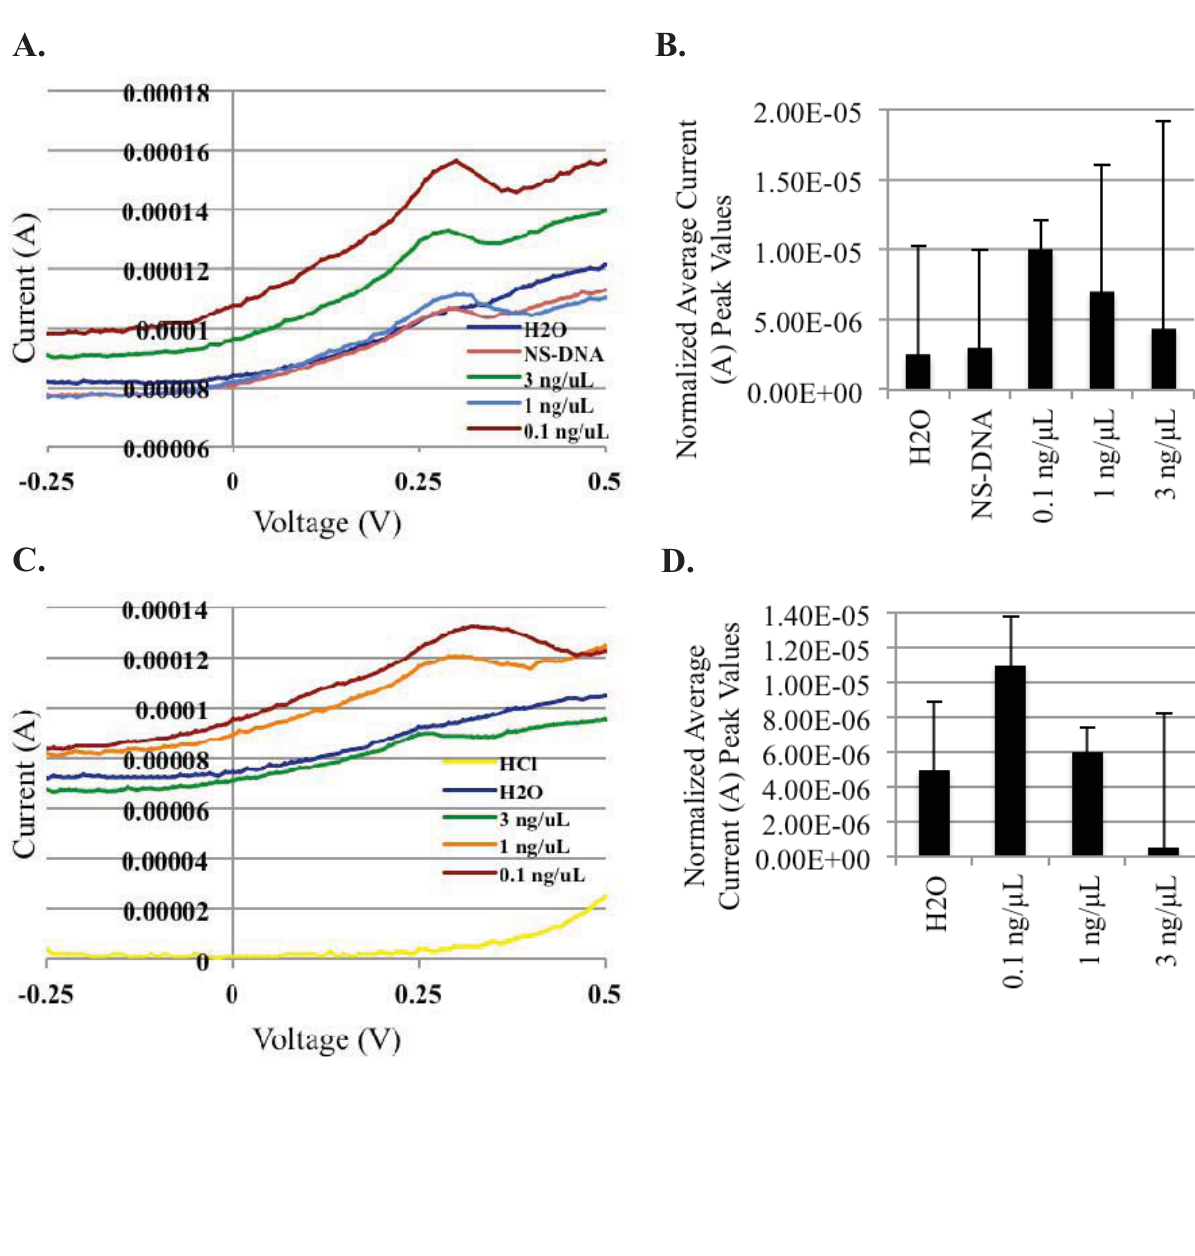
Figure 2. AuNP-DNA biosensor detection of non-PCR amplified S. enteritidis genomic DNAt. ( A ) Differential pulse voltammogram of PCR-amplified DNAt from S. enteritidis at various concentrations. ( B ) DNAt concentration vs. average differential current peak values from the voltammogram in A. ( C ) Differential pulse voltammogram of TRIzol ® extracted S. enteritidis genomic DNAt at various concentrations. ( D ) DNAt concentration vs. average O, blank control; differential current peak values from the voltammogram in C. H 2 NS-DNA, non-specific PCR amplified B. anthracis DNAt (0.1 ng/(cid:2)L) negative control; HCl, 1 M hydrogen chloride. Graphs represent the average value of duplicate samples for each condition. Error bars represent the standard deviation of the